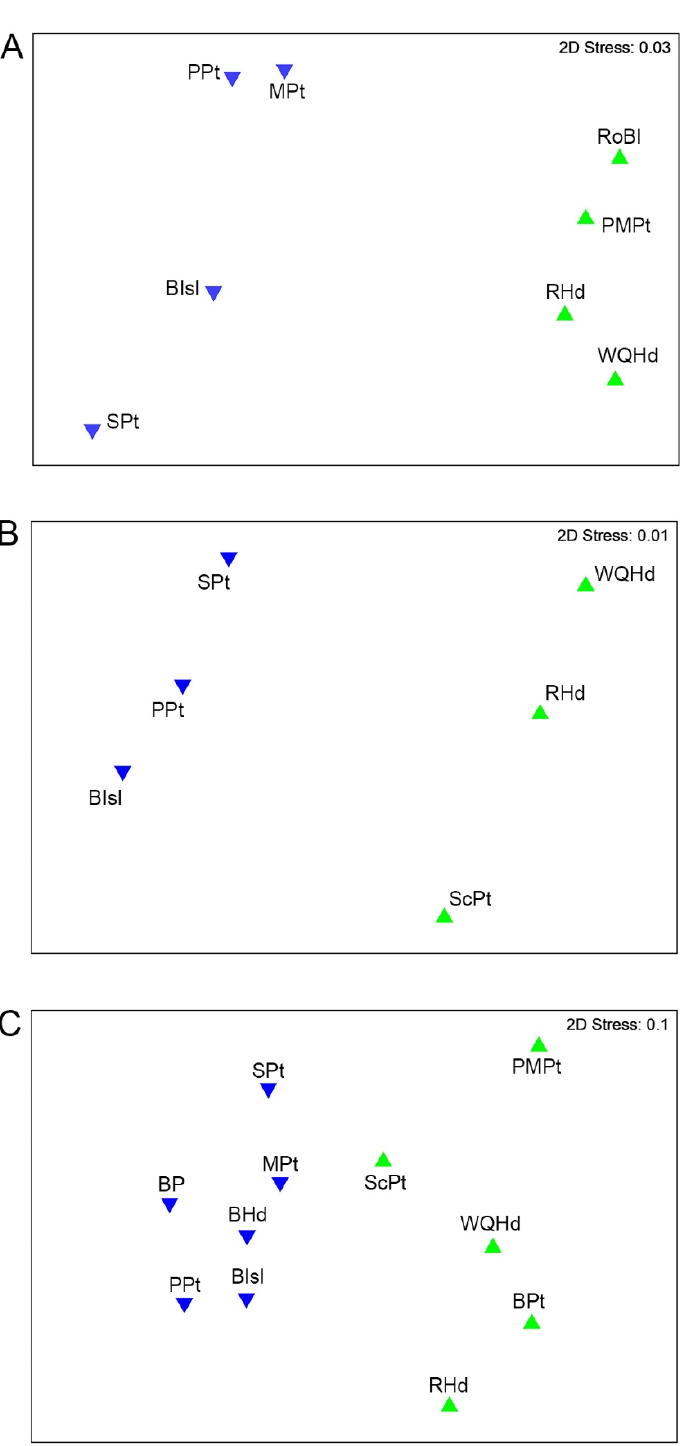
Figure 6. Ordination of rocky intertidal species assemblages by nMDS of Bray-Curtis similarities. ( A ) 2004; ( B ) 2007; ( C ) 2012. Symbology: Blue triangles, southern GoM region; green triangles, northern GoM region. Abbreviations: BIsl, Bailey Island; BHd, Bald Head; BP, Biddeford Pool; BPt, Black Point; MPt, Marshall Point; PPt, Pemaquid Point; ScPt, Schoodic Point; SPt, Sea Point; PMPt, Petit Manan Point; RHd, Red Head; RoBl, Roque Bluffs; WQHd, West Quoddy Head.